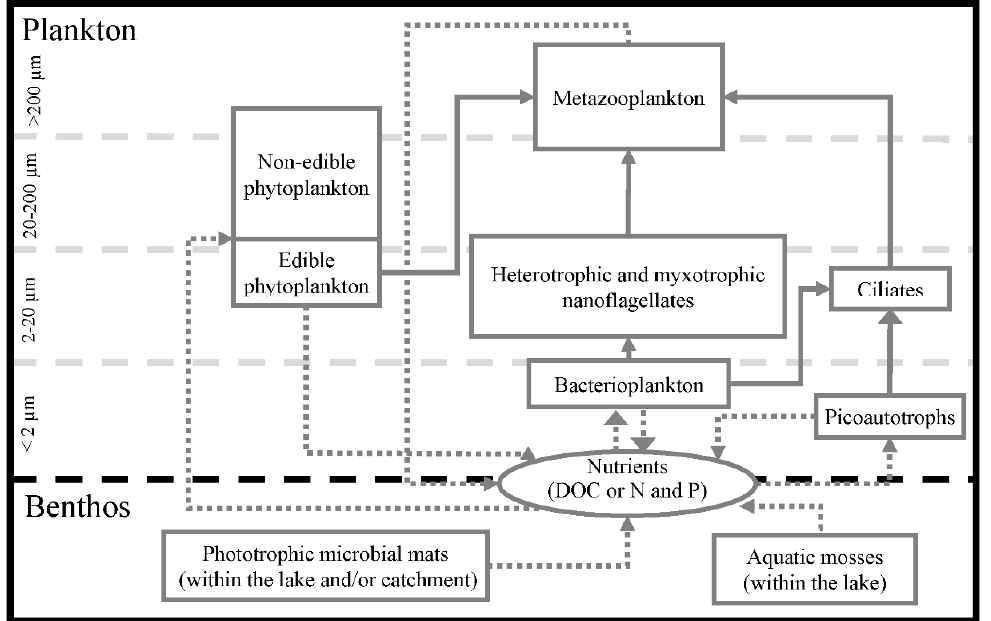
Figure 9. Conceptual model of the Lake Limnopolar planktonic microbial food web and dissolved nutrients transfers. Solid arrows represent phagotrophic organic matter transfers from the donor compartment to the consumer. Dotted arrows represent dissolved nutrients transfer. Planktonic organisms are depicted based on their size range.